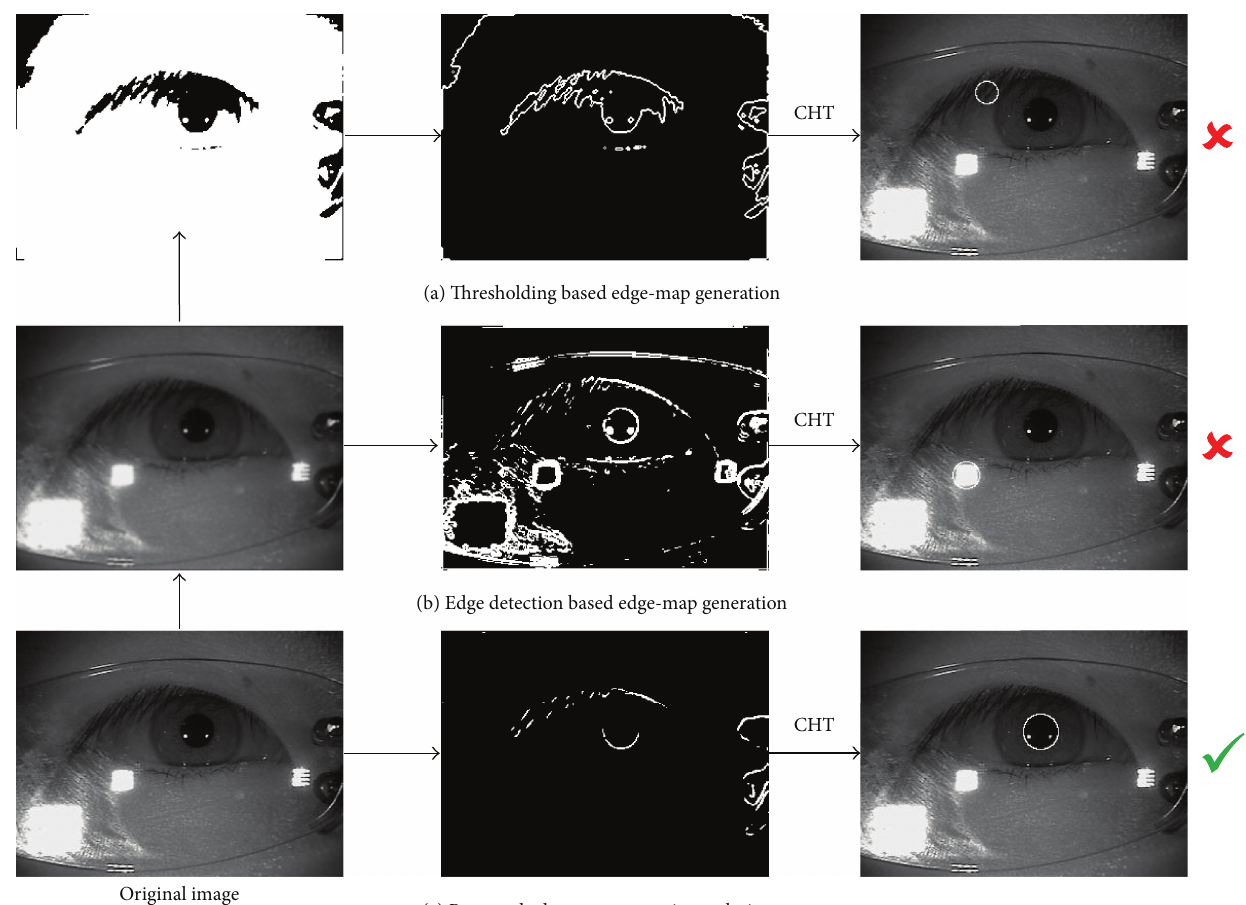
Figure 5: Edge-map generation techniques for pupil localization: (a) thresholding based technique resulting in wrong pupil localization; (b) edge detection based technique resulting in wrong pupil localization; (c) proposed technique based on combining (a) and (b) using logical ANDing, which results in correct pupil